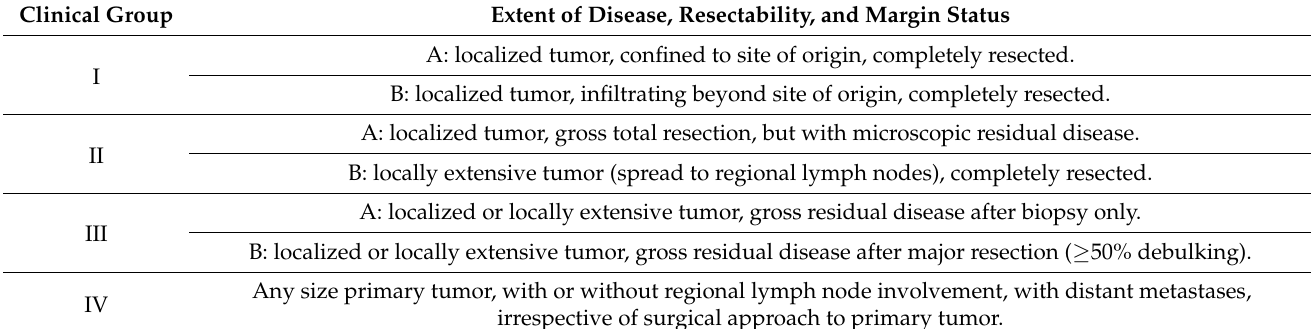
Table 2. Intergroup Rhabdomyosarcoma Study Group Clinical Classification System for Rhab-